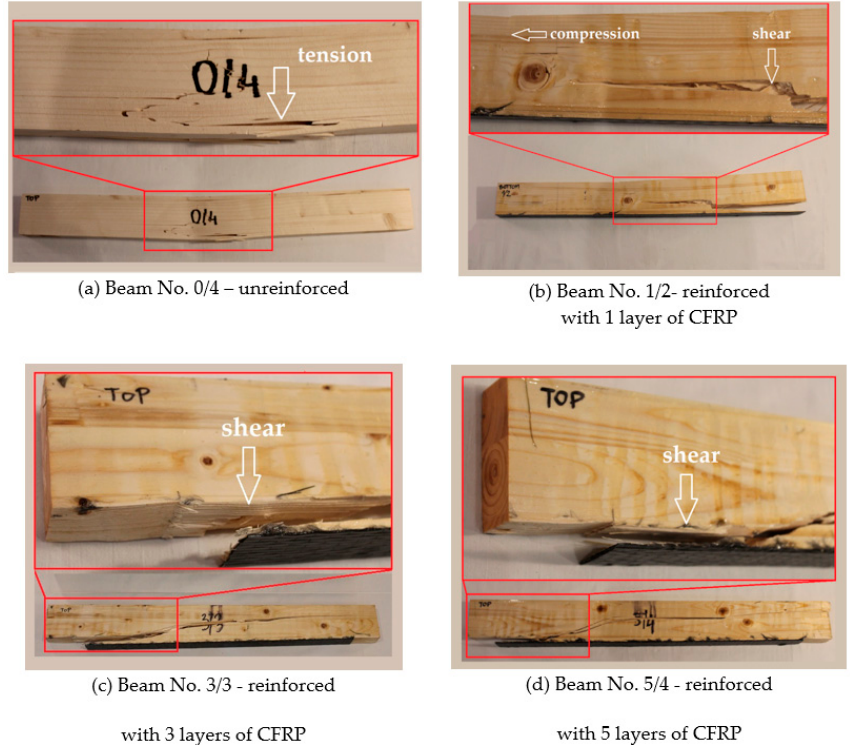
Figure 11. Representative examples of failure for each of the analyzed groups of samples. Beam No. 0/4 ( a ), Beam No. 1/2 ( b ), Beam No. 3/3 ( c ), and Beam No. 5/4 ( d ).